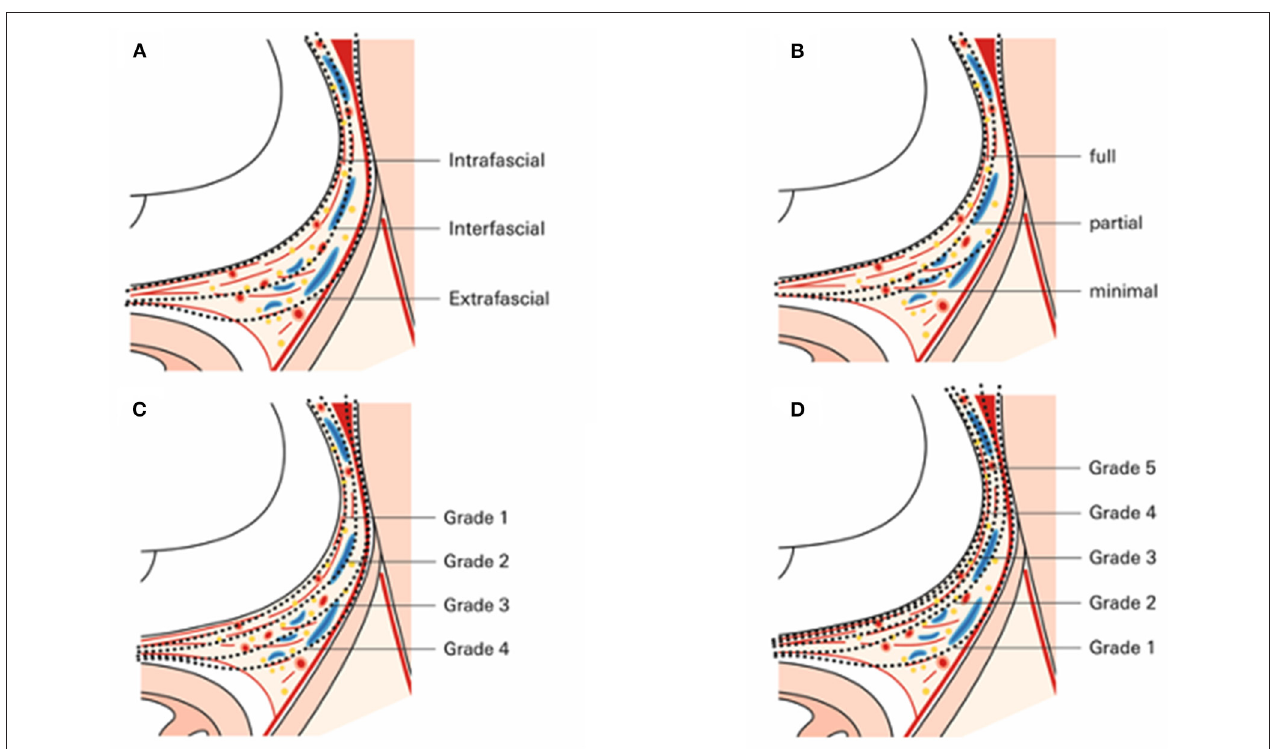
FIGURE 3 | Enlarged axial section of the prostate and its adjactent tissue at midprostate illustrating dissection planes according to (A) Walz et al. (1, 2), (B) Montorsi et al. ( 15, 58), (C) Tewari et al. (59), and (D) Schatthof et al.